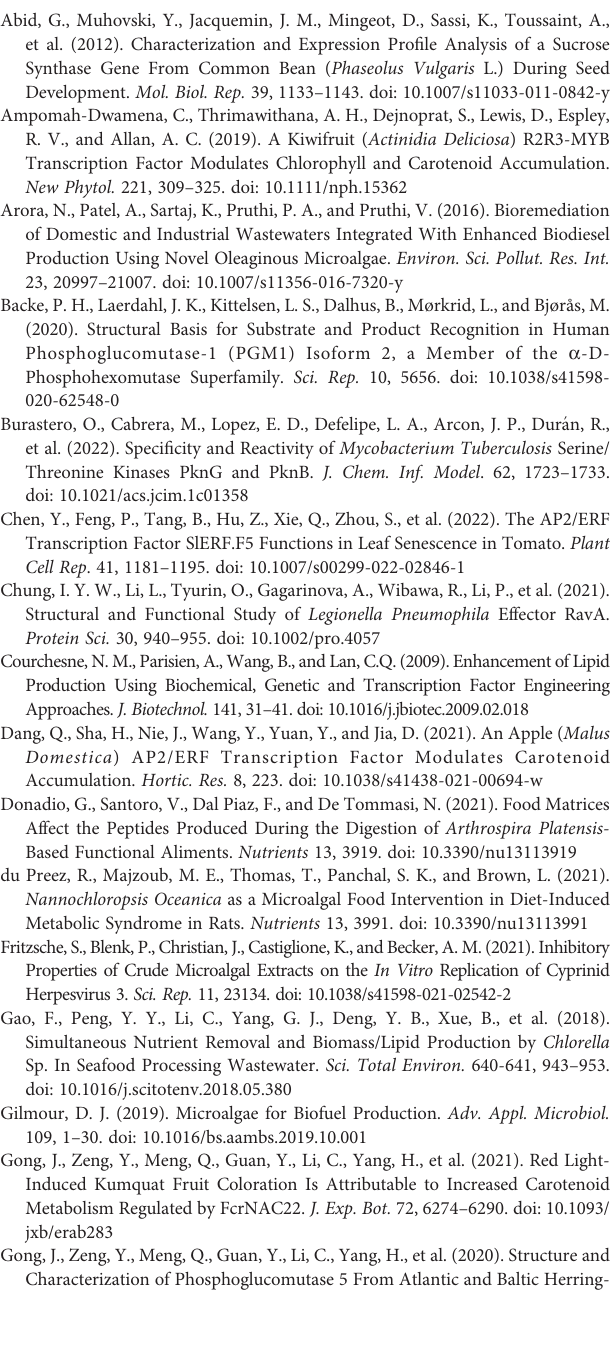
Supplementary Figure 2 | Full-length cDNA encoding three interacting proteins of DpAP2. The initiation and termination codons were underlined. (A) Interacting protein of DpAP2 (alpha-D-phosphohexomutase activity). (B) Interacting protein of DpAP2 (protein kinase activity). (C) Interacting protein of DpAP2 (DNA-binding transcription factor activity). Supplementary Figure 3 | Function prediction of three interacting proteins of DpAP2 by NetGO 2.0 software. (A) Interacting protein of DpAP2 (alpha-D- phosphohexomutase activity). (B) Interacting protein of DpAP2 (protein kinase activity). (C) Interacting protein of DpAP2 (DNA-binding transcription factor